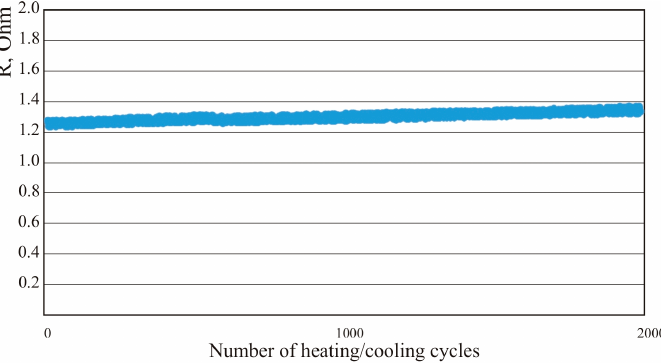
Figure 16. Dependence of heater resistance on the number of heating/cooling cycles.